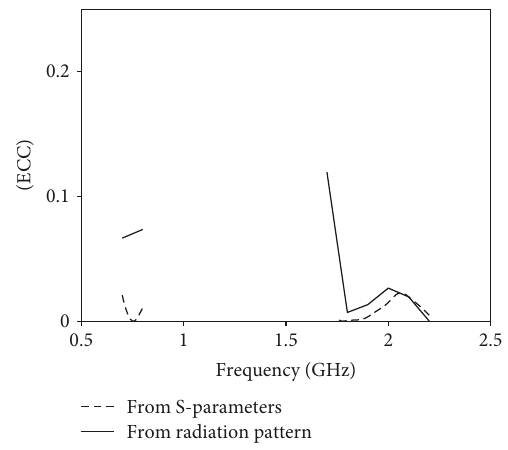
Figure 9: Calculated ECC using s-parameters and far- fi eld